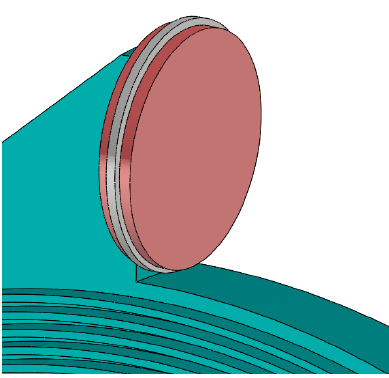
Figure 4. The piston sleeve is very Figure 4 . The piston sleeve is very short